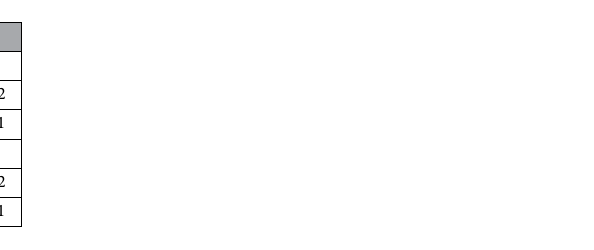
Table 2. Relationship between expression of marker genes and lacrimal gland